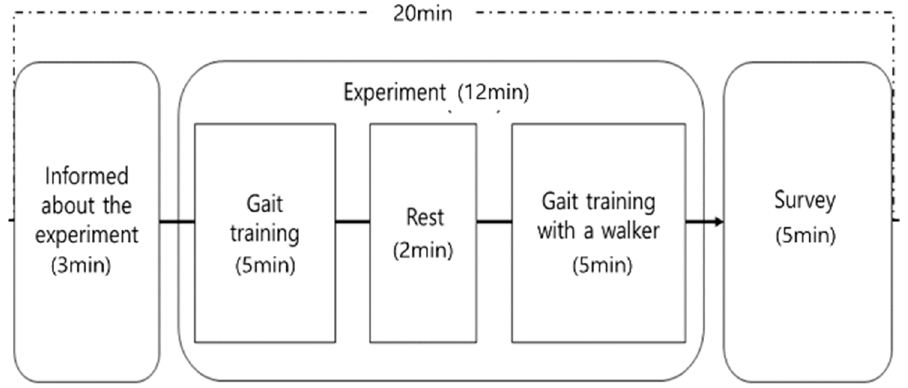
Figure 10. A procedure for usability evaluation.